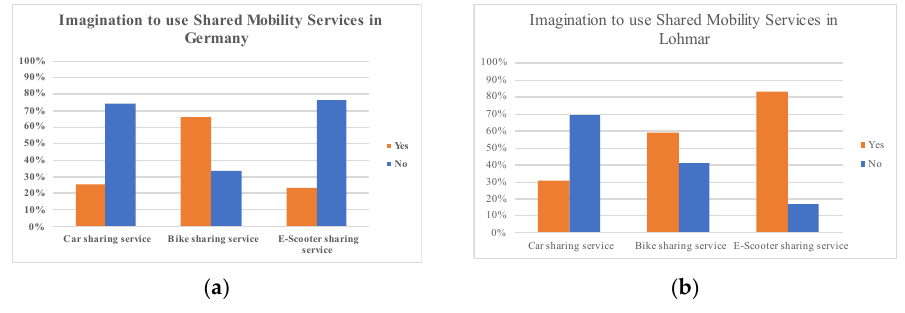
Figure 4. Imagination to use SMS: ( a ) Germany vs. ( b ) Lohmar.